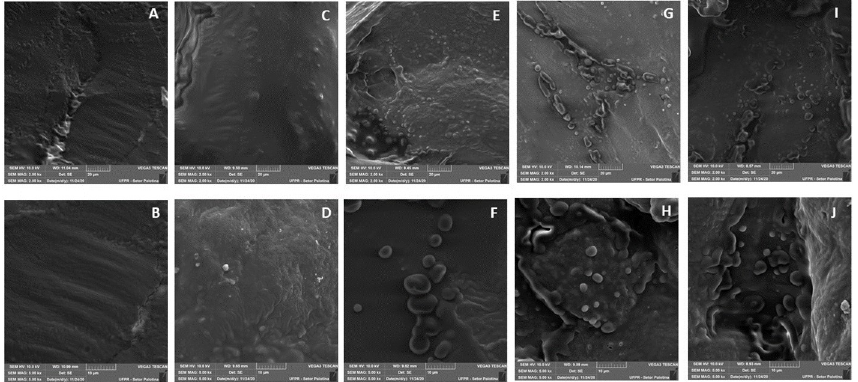
Fig 4. Scanning electron micrographs of the beef patties without oil essential e com BHT (A, B, C e D) and with essential oils (E an F—Copaiba), (G and H—Oregano) and (I and J—blend of essential oil). Magnification of 1200X,